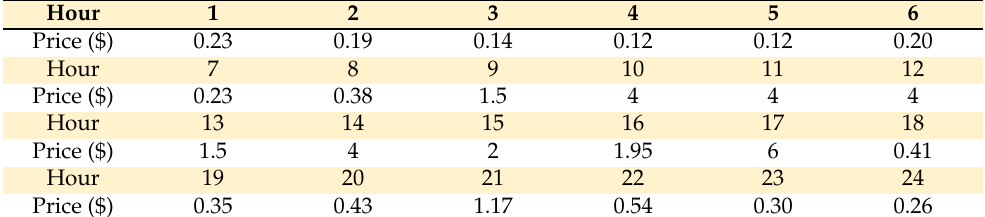
Table 3. Market price for upstream power exchange.